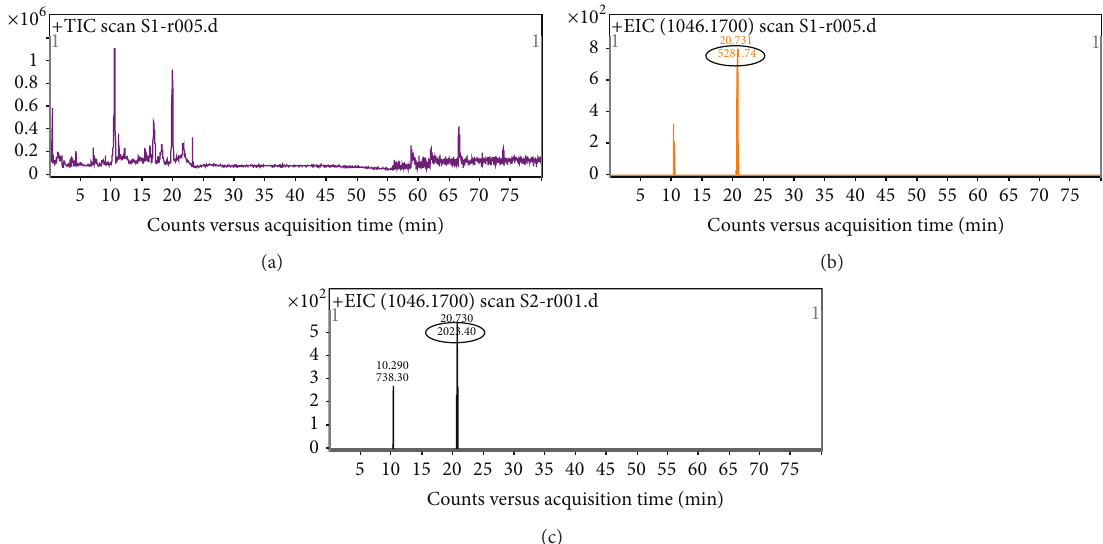
Figure 2: LC/MS with Q-TOF analysis of p5. (a) The total ion chromatogram (TIC) of 200 ng/mL p5. (b) Positive ESI mass spectra (1046.1700 𝑚/𝑧 corresponding to [M] 3+ in excellent agreement with the expected value) of 20.70±0.05 minutes of 200 ng/mL p5. The area of peak was circled. The average peak area for 200 ng/mL p5 from 6 tests was 5563.63 counts. (c) Positive ESI mass spectra (1046.1700 𝑚/𝑧 ) of 20.70 ± 0.05 minutes of 100ng/mL p5. The area of peak was circled. The average peak area for 100 ng/mL p5 from 6 tests was 2430.55 counts. The ESI-MS spectra showed no peak for 50ng/mL p5 (data not